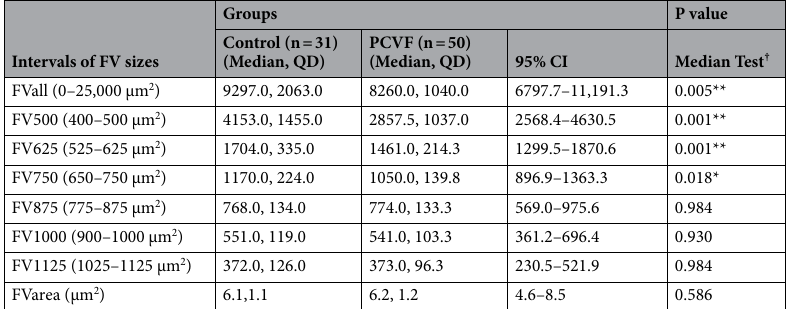
Intervals of FV